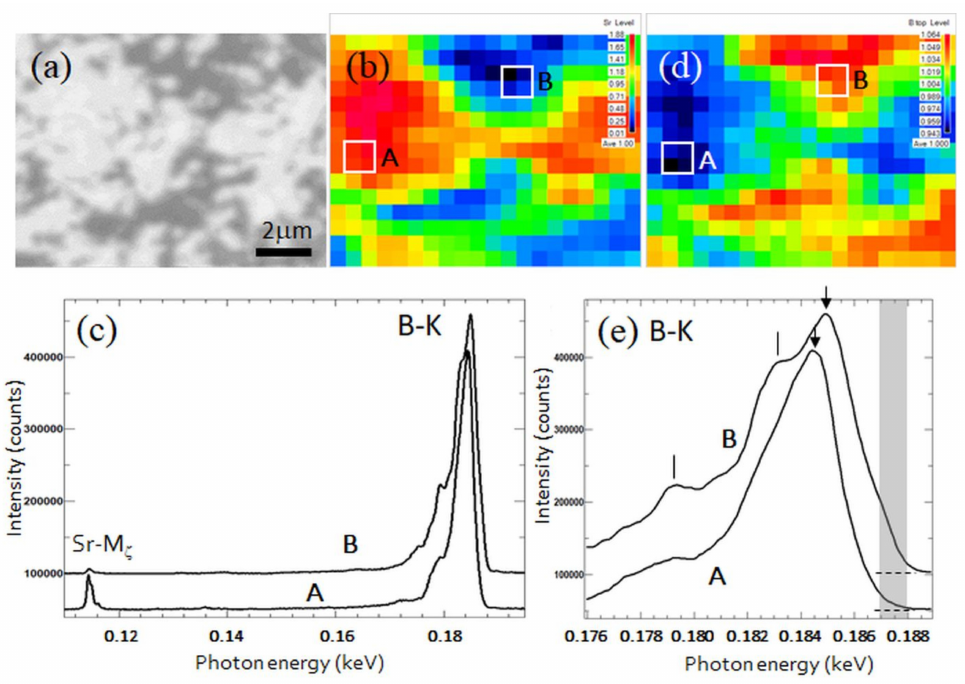
Figure 5. ( a ) BSI image, ( b ) spectra of areas A and B in ( c ), ( c ) Sr-M ζ -emission intensity map, ( d ) chemical shift map of B K-emission, ( e ) B K-emission spectra of areas of A and B in ( d ). Figure 5d is a chemical shift map prepared using the same manner for that in Figure